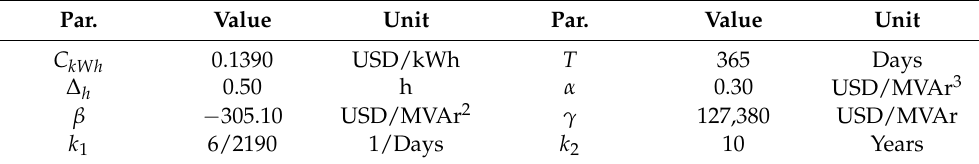
Table 1. Parameters used to evaluate the mathematical model Par. Value Unit